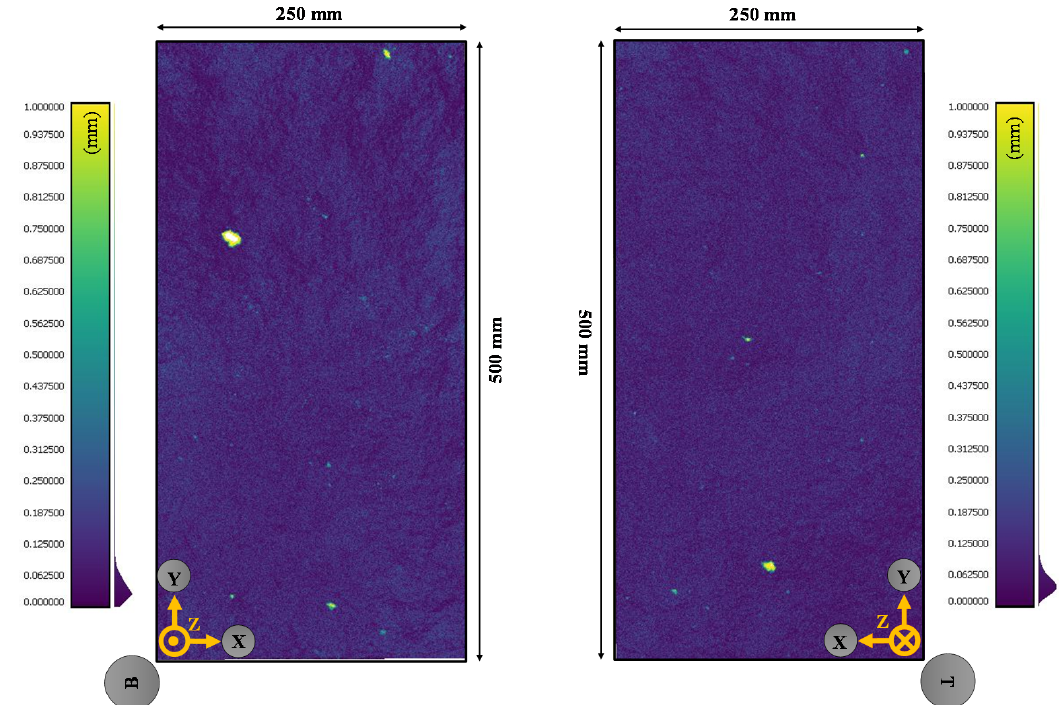
Figure 8. Photogrammetry data of the medium sample (500 mm × 250 mm), ( a ) initial topography, ( b ) sheared topography and ( c ) damaged areas based on the comparison between pre-shearing and post-shearing stages.